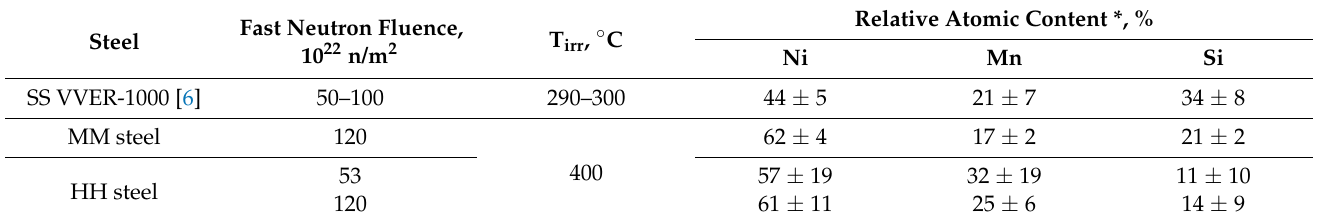
Table 4. Chemical composition of Ni-Si-Mn precipitates (major elements) in MM and HH steels after irradiation at 400 ◦ C to various neutron